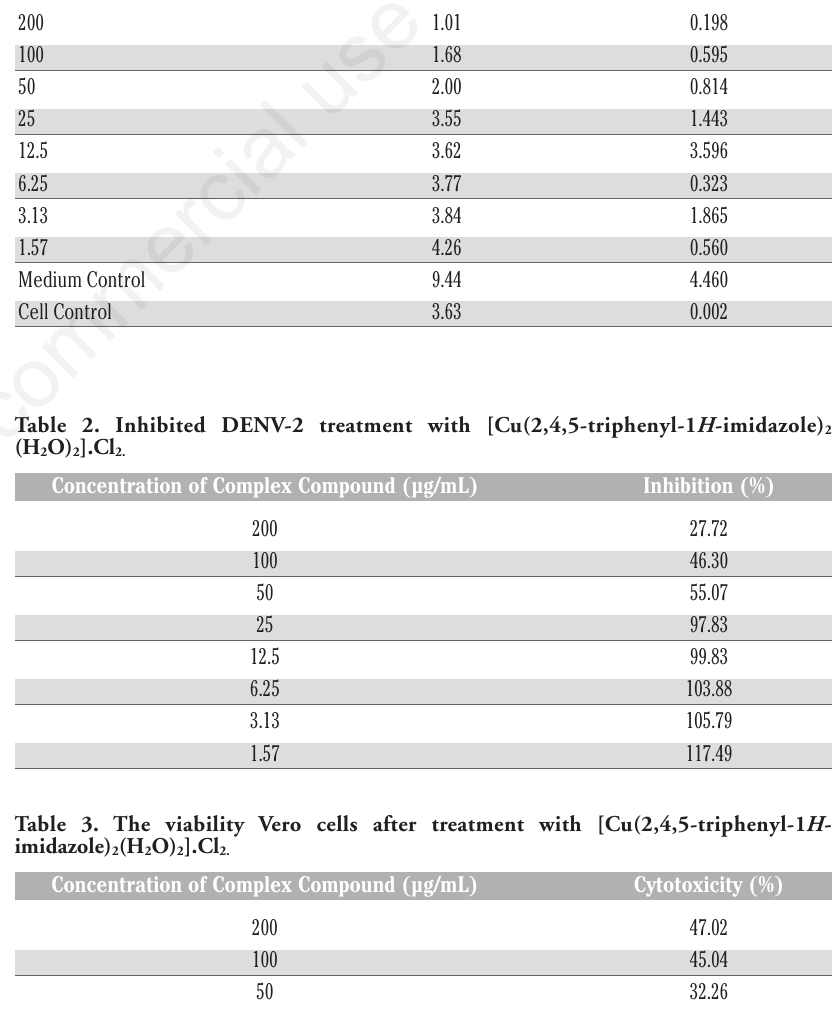
Table 1. Luminescence of DENV-2 treatment with various concentration of [Cu(2,4,5- triphenyl-1 H -imidazole) 2 (H 2 O) 2 ].Cl 2 with p value <0.05 Treatment (µg/mL)